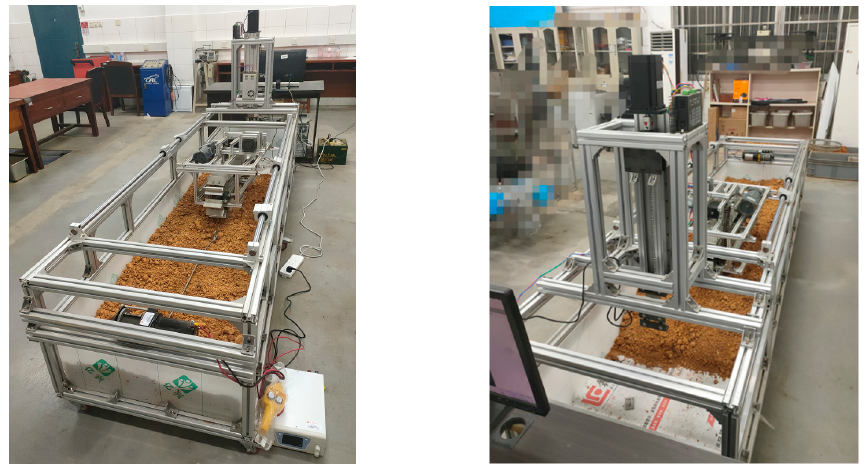
Figure 6. The prototype of the experimental platform in the laboratory.